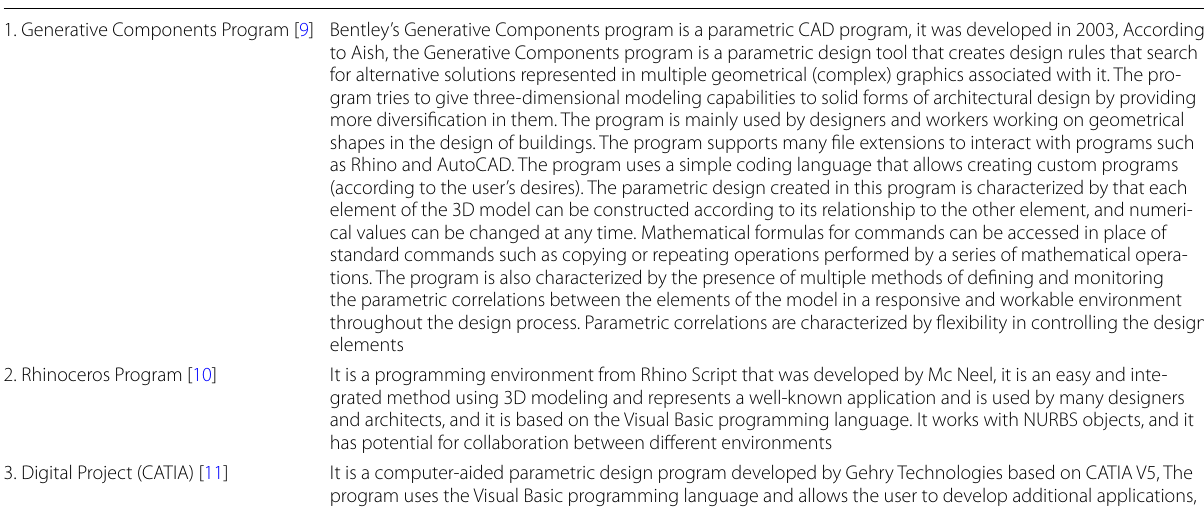
Table 1 Parametric design programs The